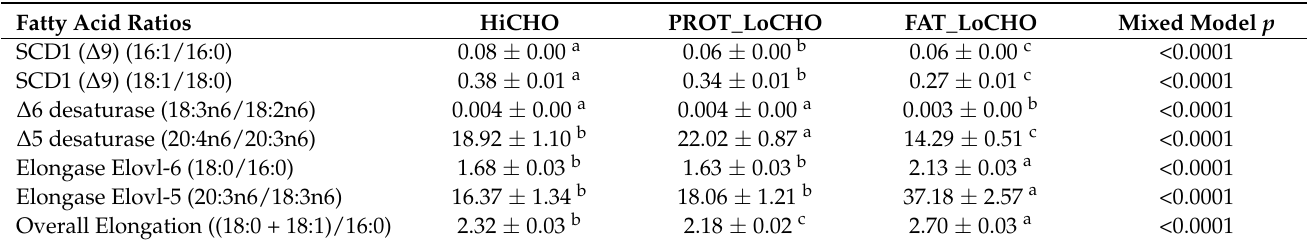
Table 7. Elongation and desaturation fatty acid ratios.